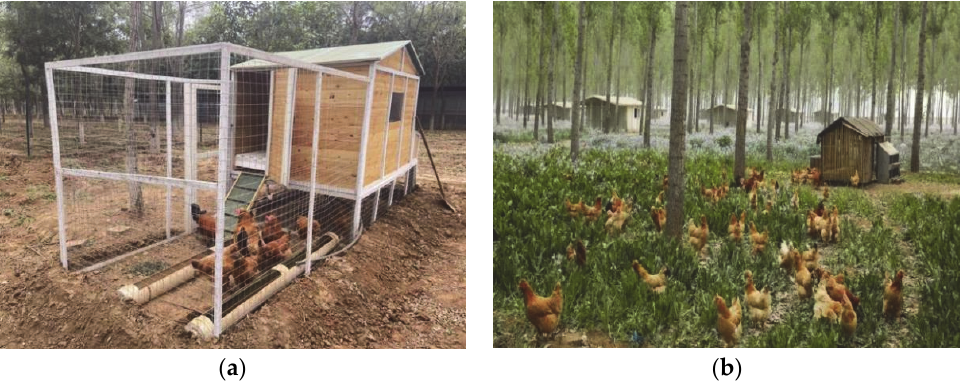
Figure 3. The ‘forest–grass–chicken’ ecological farming scheme. ( a ) The small and low-density mobile house. ( b ) Laying hens foraging freely in woodland and grassland. Note: ( a ) from the Official Network of the People’s Government of Fangshan District, Beijing: http://www.bjfsh.gov.cn/zhxw/fsdt/202010/t20201009_40007024.shtml (accessed on 4 June 2022); ( b ) from Beijing Agriculture and Rural Bureau: http://nyncj.beijing.gov.cn/nyj/snxx/gzdt/10937948/index.html (accessed on 8 June 2022).